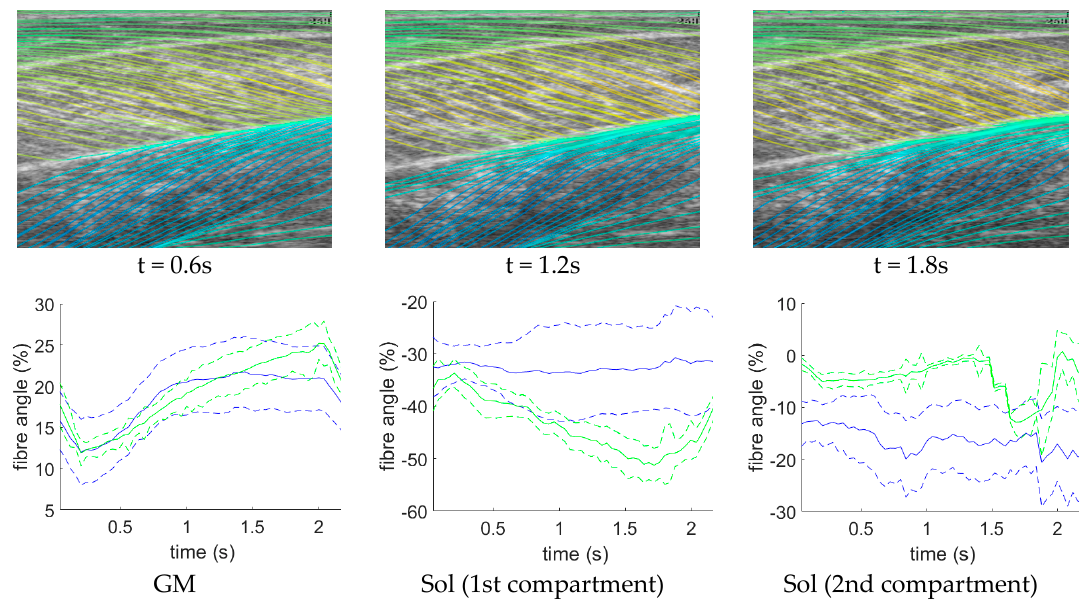
Figure 6. DCNN fibre orientation time-series. Left: shows fibre traces predicted by the DCNN at time points corresponding to a maximum voluntary contraction beginning at 0 s and ending at 2.2 s, where the time point is indicated below each graphic. Notice the sharp increase in angles of the fibres in the GM muscle as the contraction develops from top to bottom graphic (0.6–1.8 s). Right: shows, for a representative participant, average fibre angles, predicted by the DCNN over a maximum voluntary contraction, for each muscle (solid blue line), plus and minus 1 standard deviation (dashed blue line) and average fibre angles of the ground truth for the same contraction (solid green lines), plus and minus 1 standard deviation (dashed green lines). For GM, agreement is high until the latter part of the contraction, whereas for Sol (1 and 2), estimation appears to have failed, although compartment 1 does show an increased standard deviation which tracks the increase in angle, which may indicate curvature in the model and not in the labels. We note that this approach is superior to feature tracking [34] because there is no possibility of tracking drift with the proposed method. Please see supplementary material for a video of the fibre line traces in this figure.